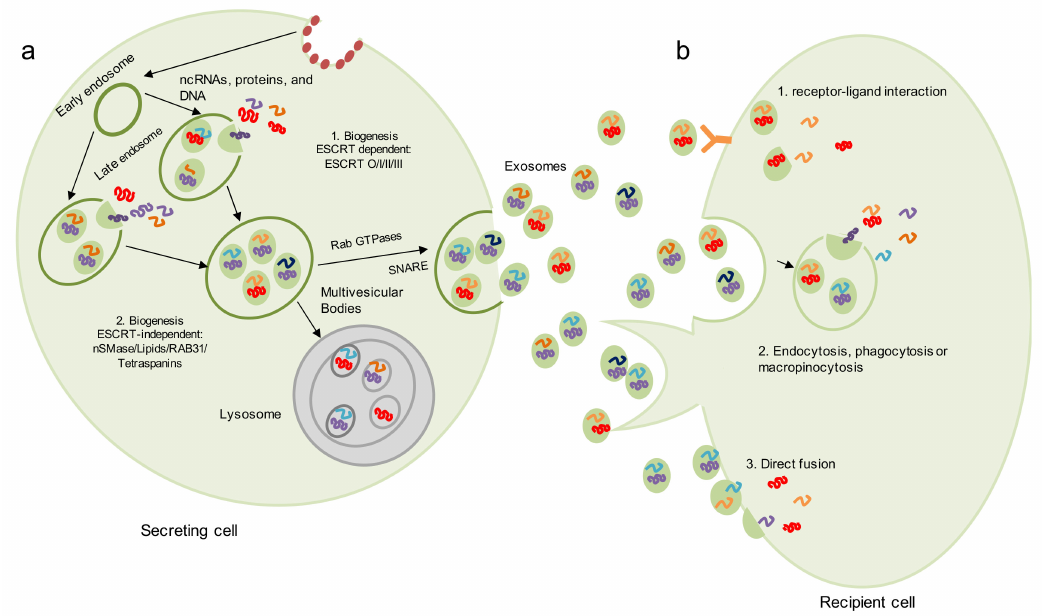
Figure 1. Biogenesis of exosomes and cell-to-cell communication. ( a ) Exosome biogenesis starts with the inward budding of the plasma membrane and the participation of proteins, such as clathrin. Endocytosis results in the formation of an early endosome, which encapsulates cellular proteins and genetic material present in the cytoplasm, becoming a late endosome. Then, multivesicular bodies (MVBs) containing exosomes are formed. The generation of exosomes can occur by two main pathways: (1) a ESCRT-dependent pathway and (2) a ESCRT-independent pathway. MVBs can be directed to the lysosome for degradation and recycling of MVB components or to the plasma membrane, and exosomes are released into the extracellular space by Rab small GTPases or R-SNARE. ( b ) Secreted exosomes can be taken up by recipient cells through several mechanisms, including (1) receptor-ligand interaction, (2) exosomal internalization by endocytosis, phagocytosis or micropinocytosis and (3) direct membrane